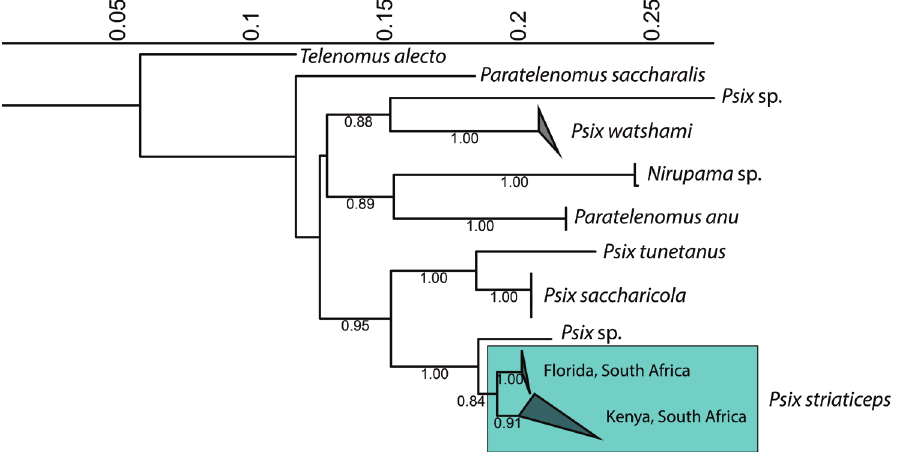
Figure 11. K2P Neighbor-joining tree of COI for Psix group of genera. Bootstrap support values over 80 are labelled on the